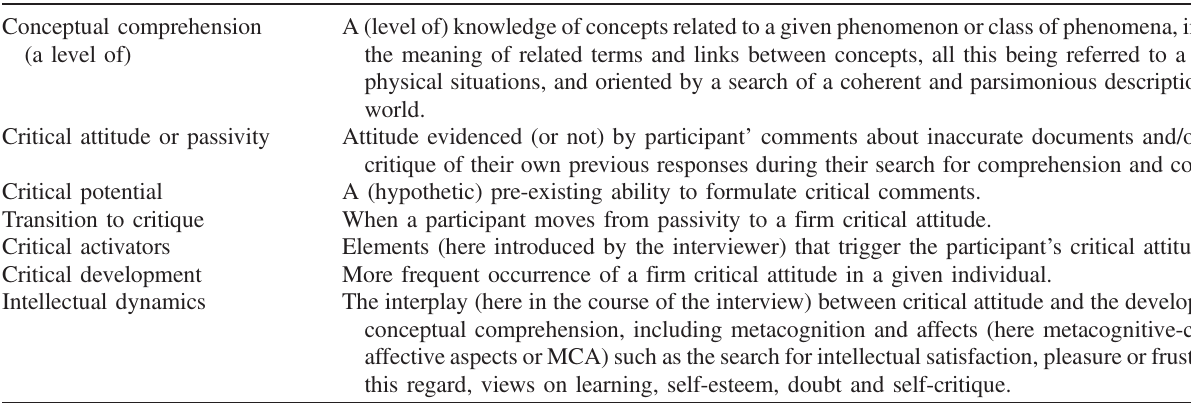
TABLE I. Some key ideas informing the research questions. Conceptual comprehension (a level